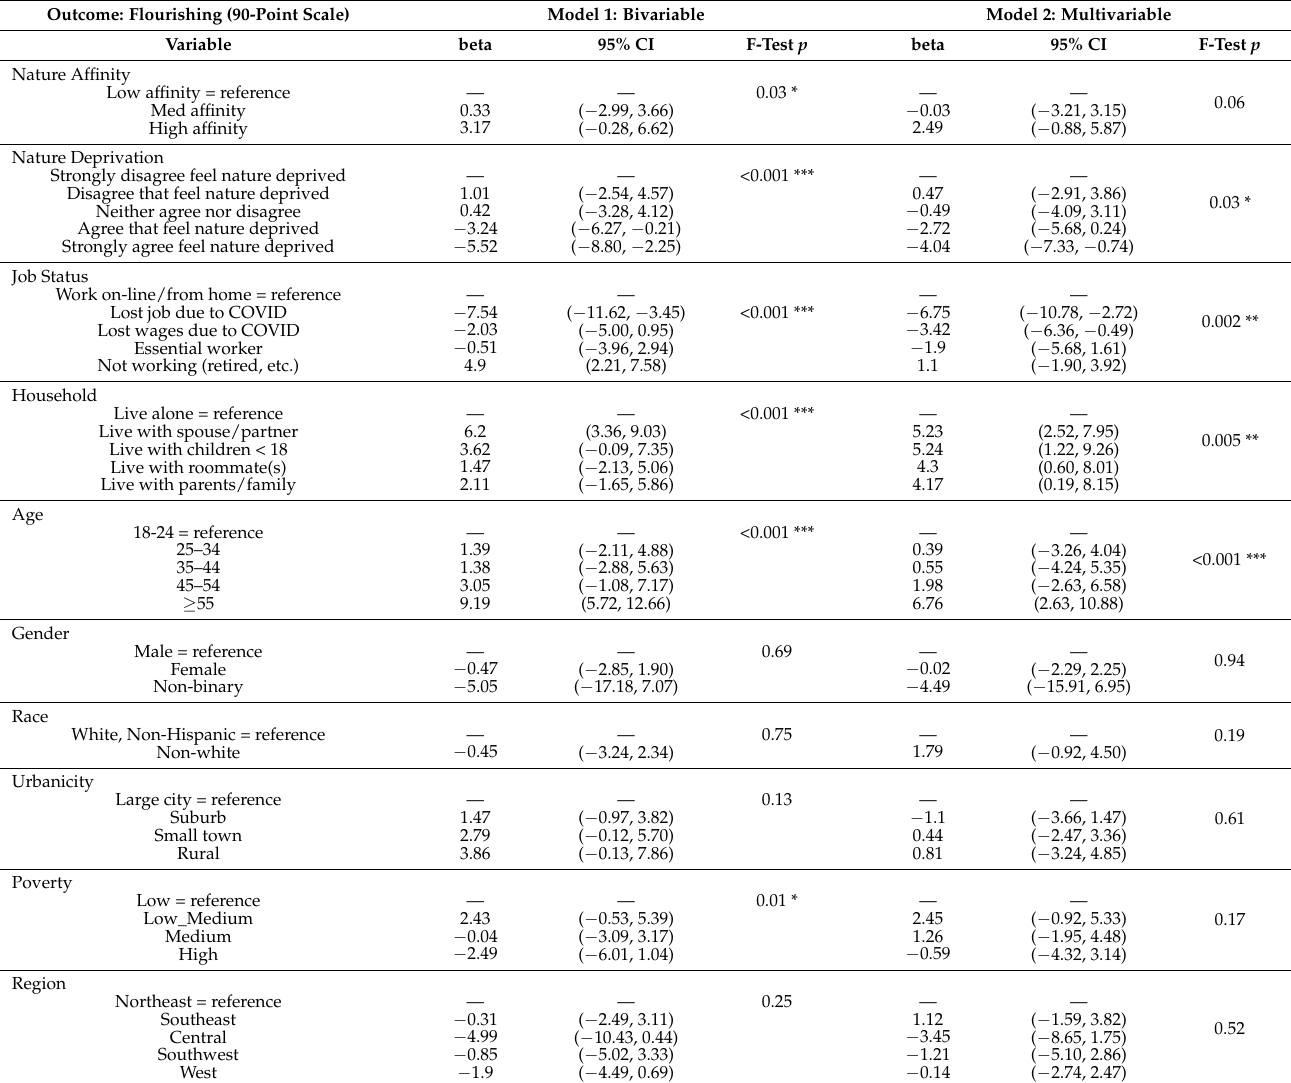
Table 3. Linear regression analysis of bivariable model and multivariable model of individual flourishing adjusted for age and urbanicity under COVID-19 lockdown